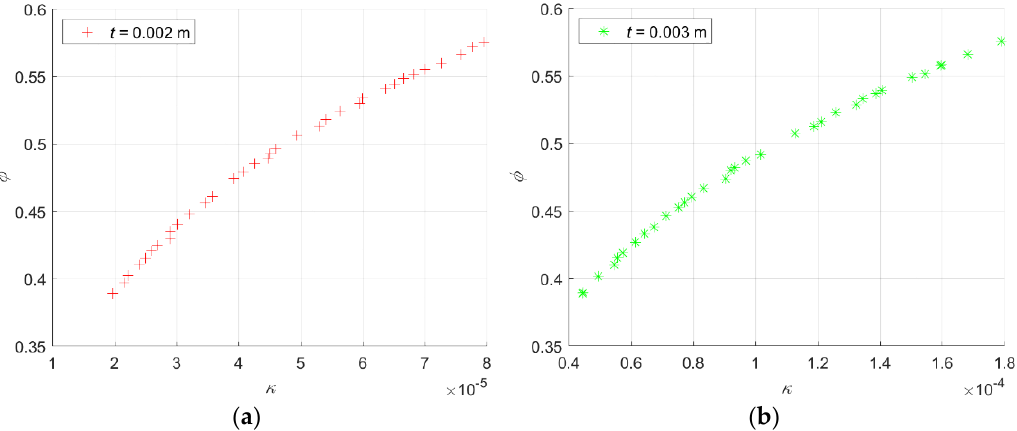
Figure 6. Pareto front of the nondimensional tension stiffnesses and buckling load. ( a ) t = 0.002 m, ( b ) t = 0.003 m.